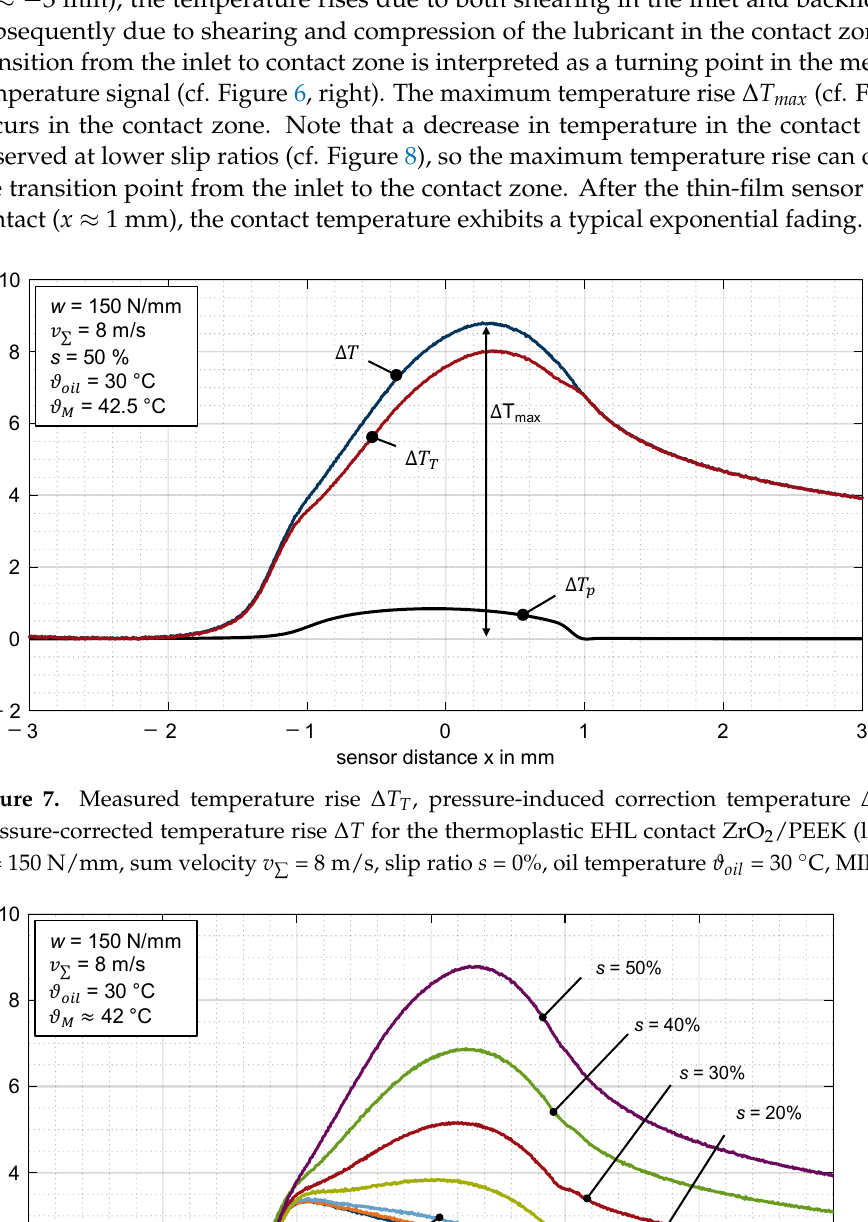
Figure 8. Temperature rise ∆ T for different slip ratio s = {0; 5; 10; 20; 30; 40; 50}% for the thermoplastic EHL contact ZrO 2 /PEEK (line load w = 150 N/mm, sum velocity v ∑ = 8 m/s, oil temperature ϑ oil = 30 ◦ C, MIN100).